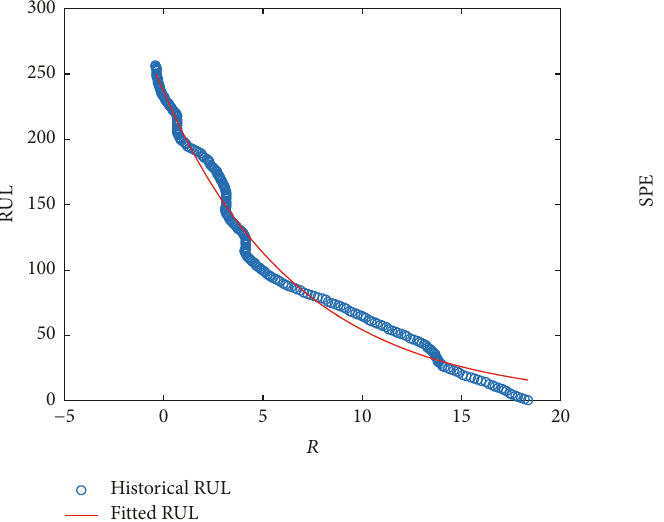
Figure 7: Online early fault detection based on WF-PCA.